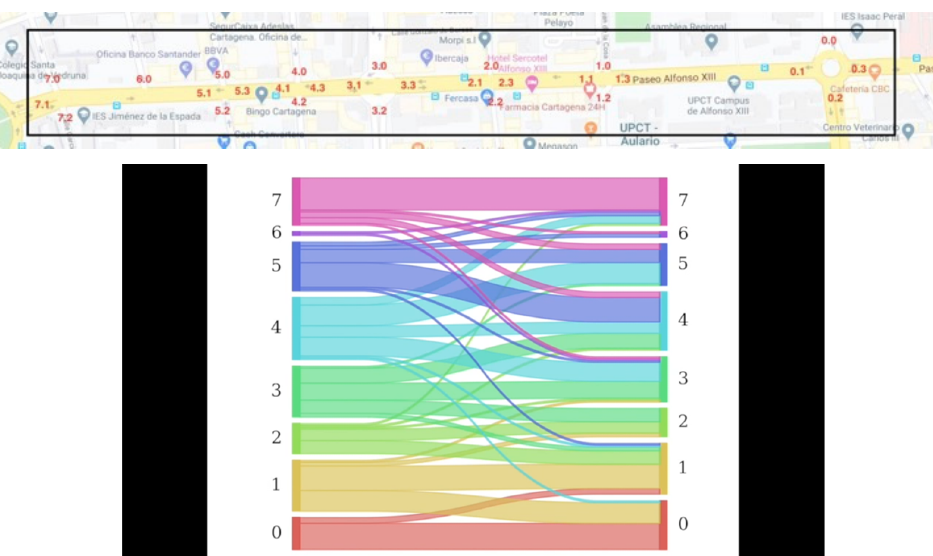
Figure 3. Example of the experimental tests before deployment; ( a ) outdoor; ( b ) indoor.